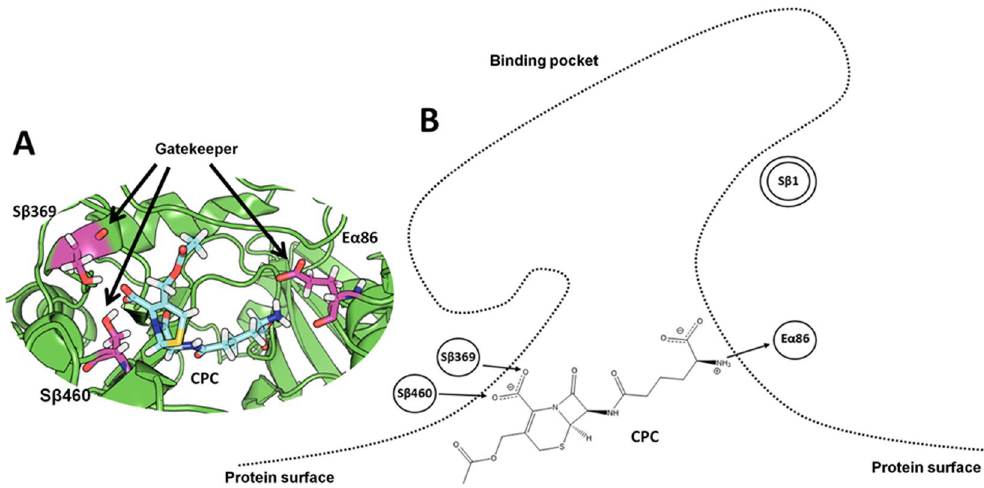
Figure 3. CPC at the entrance to the binding pocket. In the left part ( A ) the structural representation of CPC at the entrance to the binding pocket, CPC represented in cyan stick mode and the gatekeeper residues (S369 β , S460 β , E86 α ) in magenta stick mode. In the right part ( B ) the schematic representation: the catalytic serine (S1 β ) is labeled by a double circle, the gatekeeper residues (S369 β , S460 β , E86 α ) at the entrance to the binding pocket are indicated as circles; arrows indicate the electrostatic interactions between amino acid side chains and CPC.